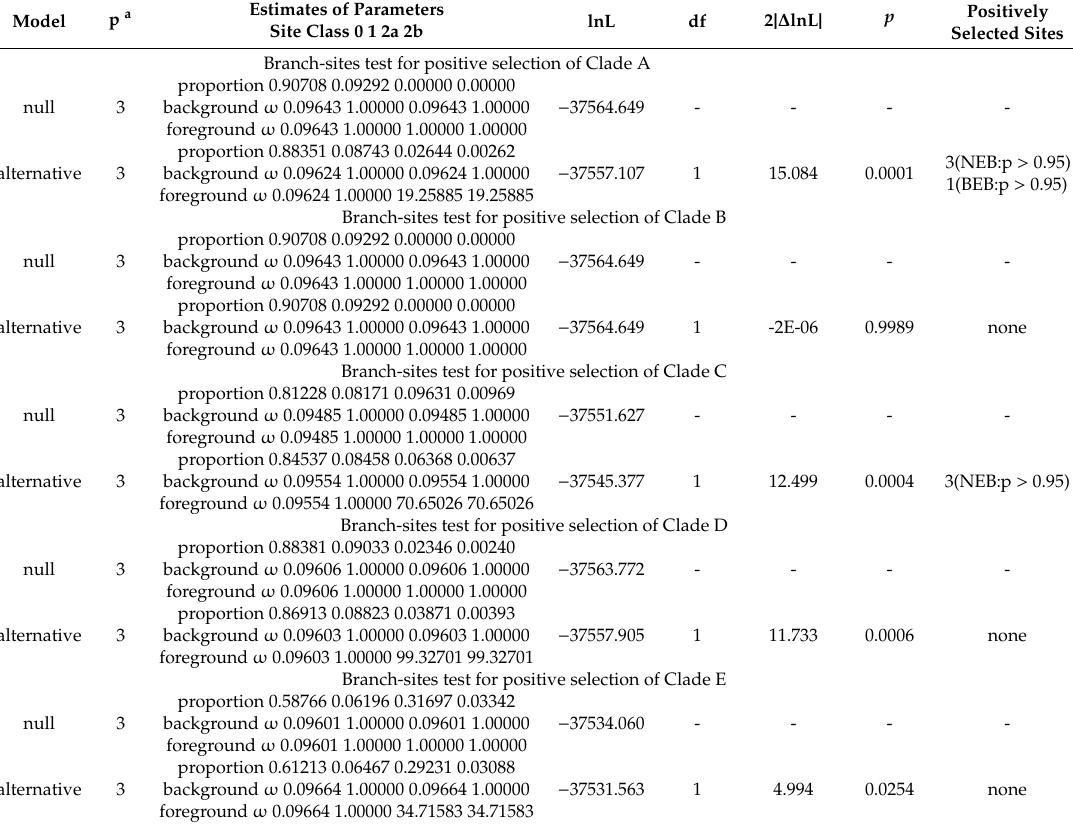
Table 3. Parameter estimates and likelihood ratio tests for the branch-site